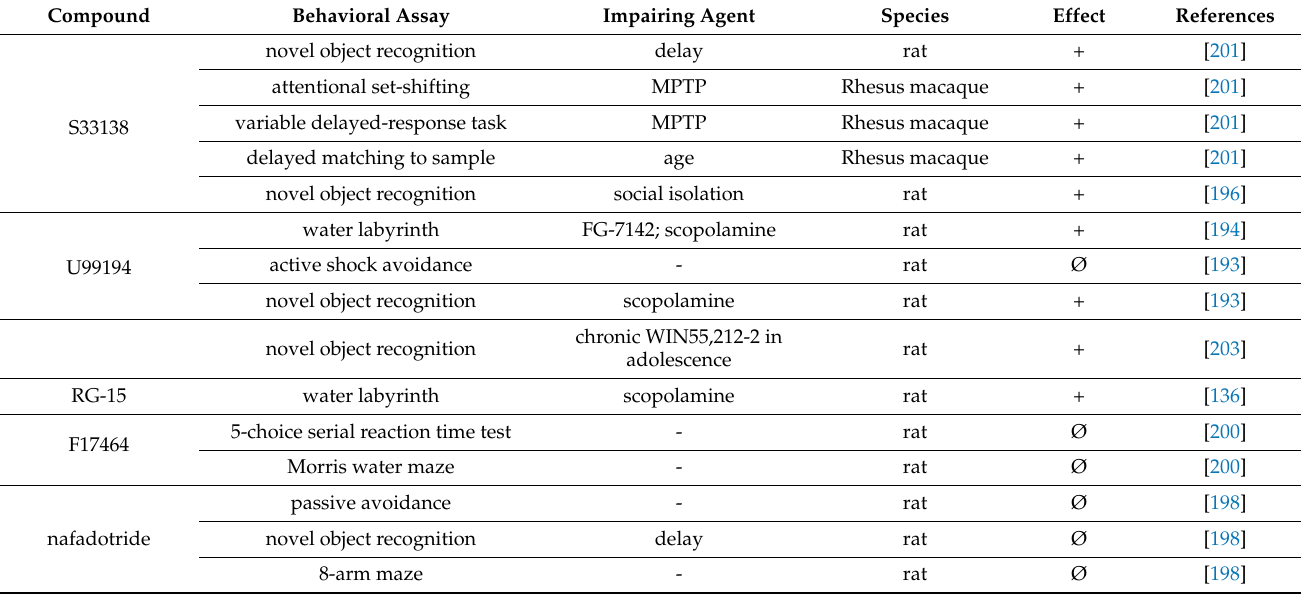
Table 3. Cognitive effects of D3R preferring, selective D3R/D2R antagonists.